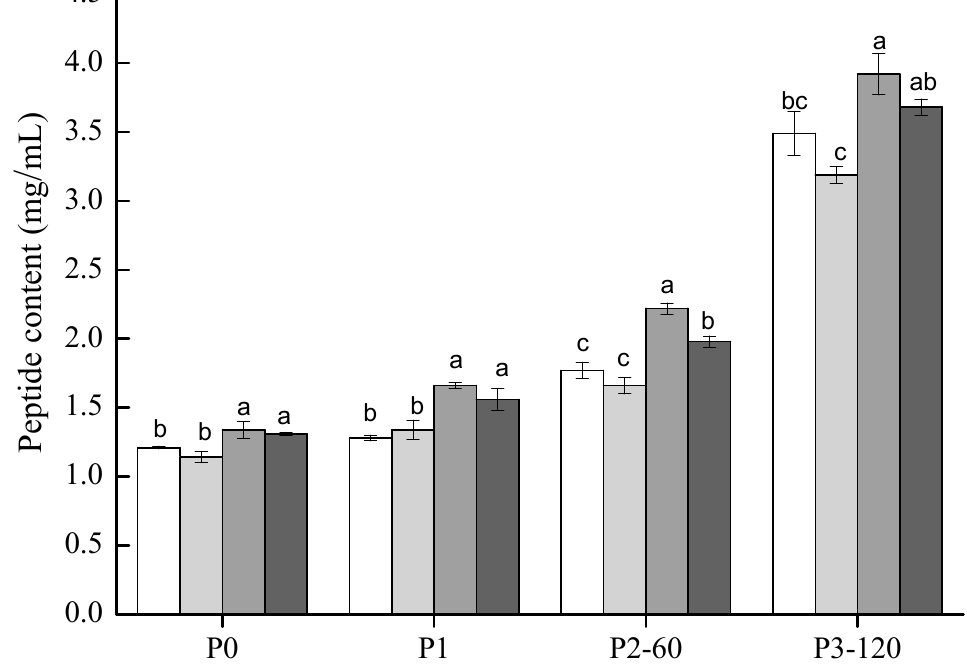
Figure 5. Peptide contents (<10 kDa) of soymilk (white), ST (light gray), SG (gray) and STG (black) samples at different phases of in vitro GIS. Within the same digestive phase, different lowercase letters indicate a significant difference ( p < 0.05).